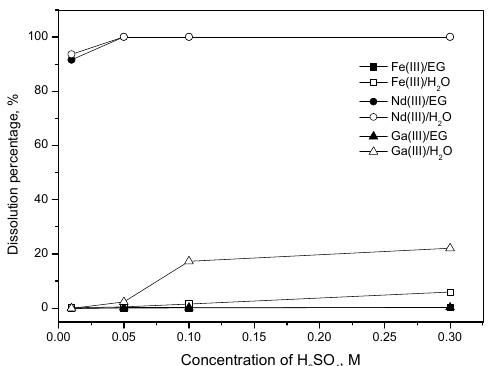
Figure 2. Effect of H 2 SO 4 concentration in either EG or H 2 O on the leaching of oxide mixtures. Operation conditions: pulp density = 50 g/L, T = 80 °C, time = 90 min, stirring speed = 400 rpm.